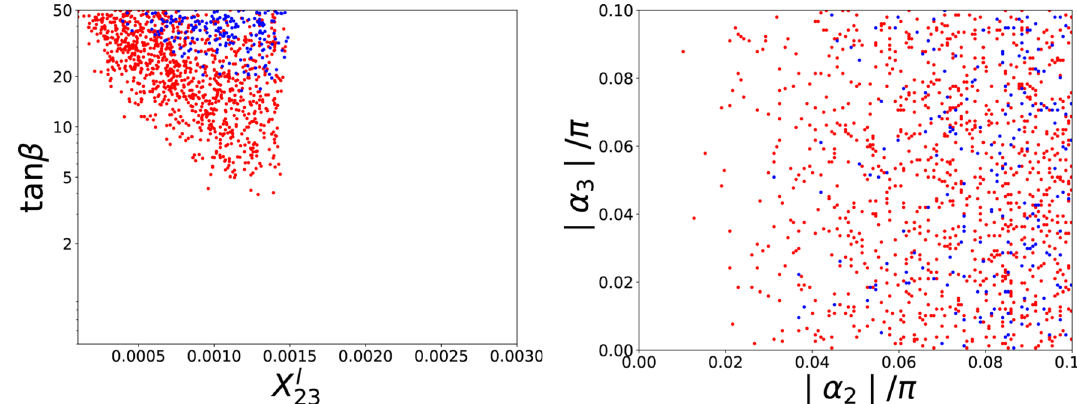
Figure 7 . The allowed parameter region satisfying the LFV constraints and muon g − 2 value within 1 × 10 − 10 < ∆ a µ < 50 × 10 − 10 for X l 2 σ